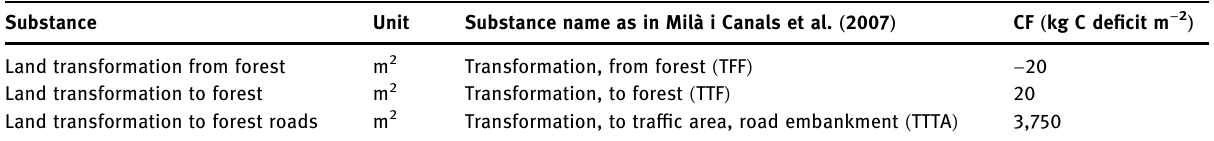
Table 3: CFs for transformation fl ows from Milà i Canals et al. [ 29 ]